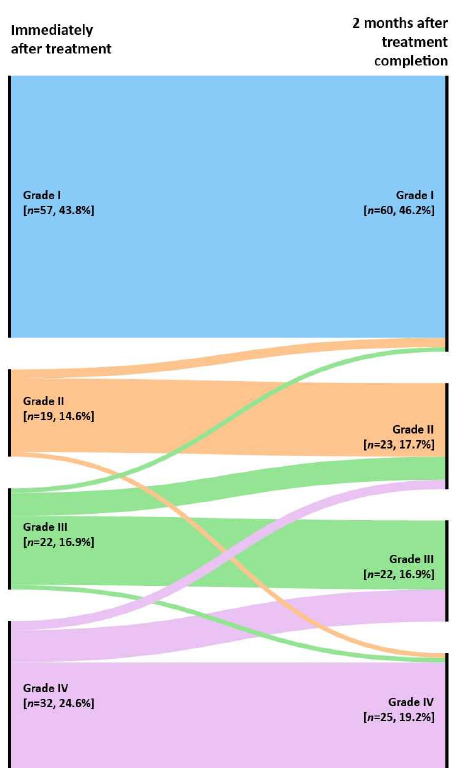
Figure 2. The alluvial diagram showed the distribution of the recovery grade from immediately after the treatment (left nodes) to 2 months after treatment completion (right